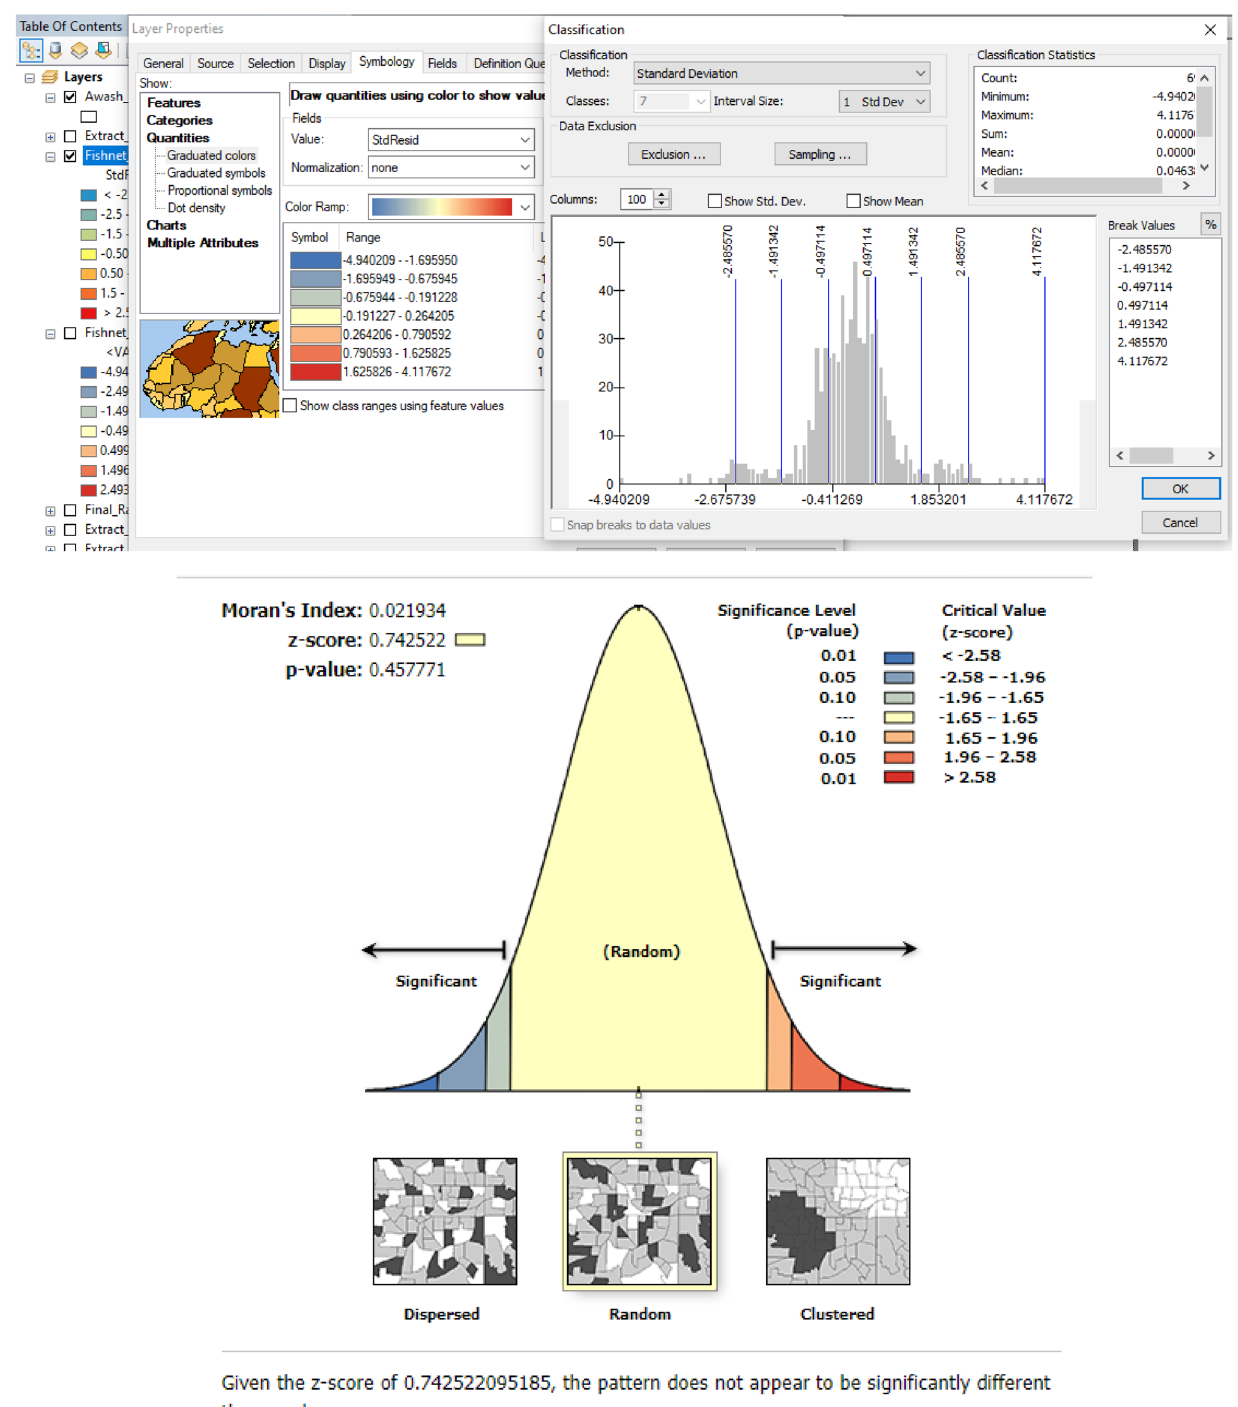
Figure 8. Distribution of standard residuals of exploratory regression. This figure was created using ArcGIS 10.3.1